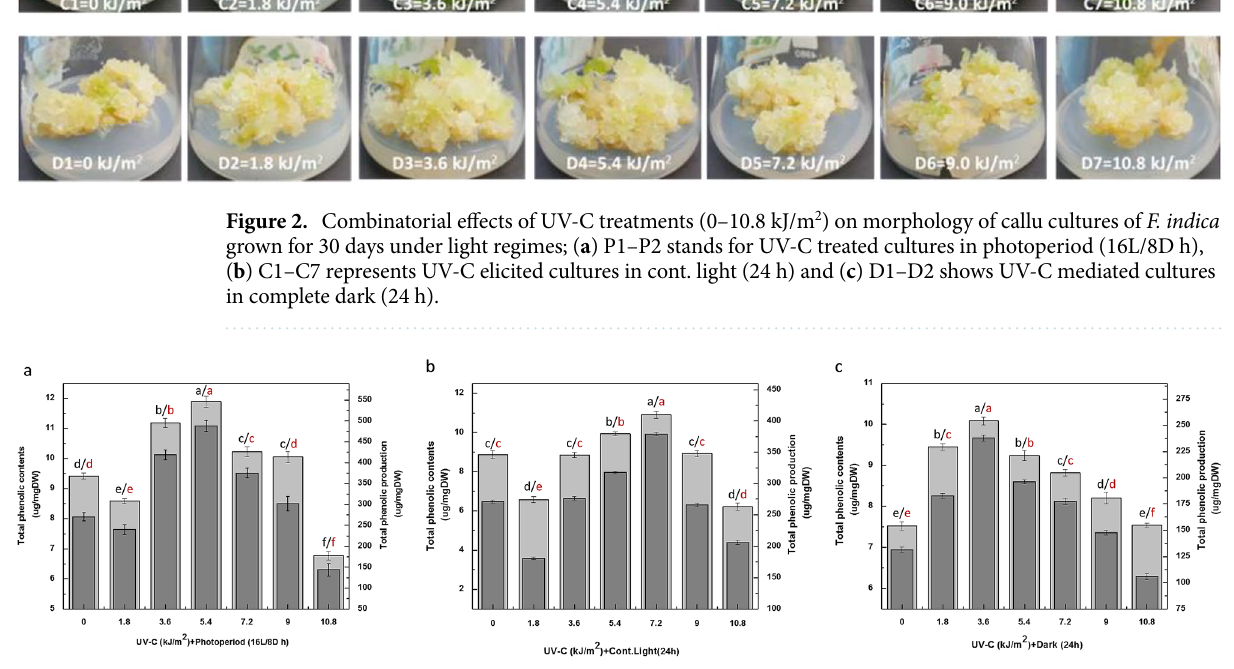
accumulation of phenolics (total phenolics contents (TPC): 11.8 μg GAE/mg DW, total phenolics production (TPP): 488.1 μg GAE/mg DW) was found in cultures under photoperiod (16L/8D h) at UV-C dose (5.4 kJ/m 2 )